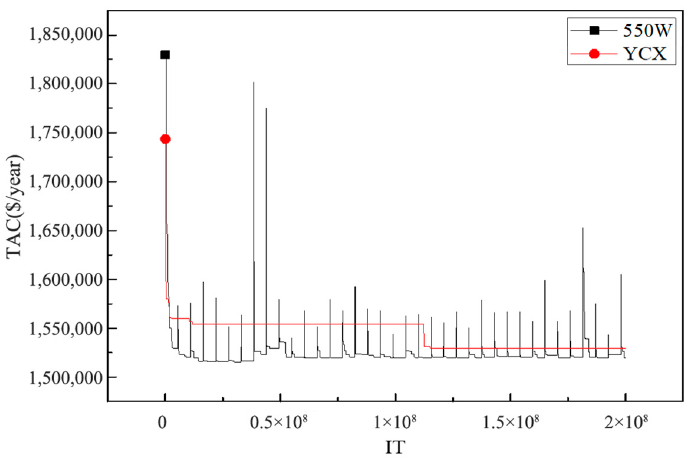
Figure 6. Timely TAC curve of the participatory evolutionary strategy for Case 2.